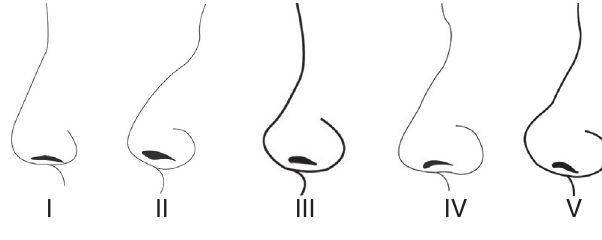
Figure 4 Nasal profiles in young Turkish females.